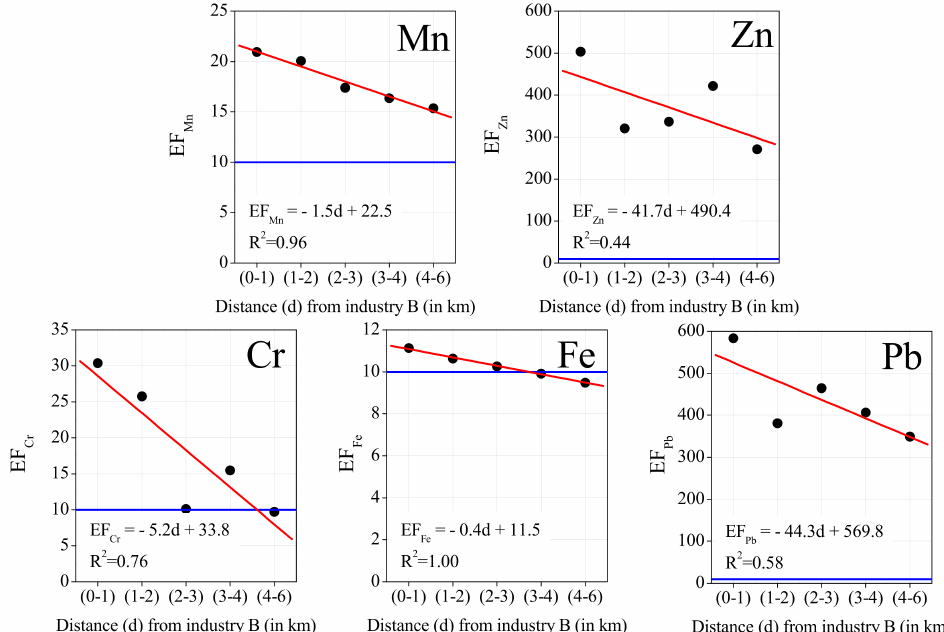
Figure 8. Mean Enrichment Factors (EFs) versus distance to the steelworks. The blue line represents the threshold of 10, the accepted minimum for the enrichment from a non-crustal